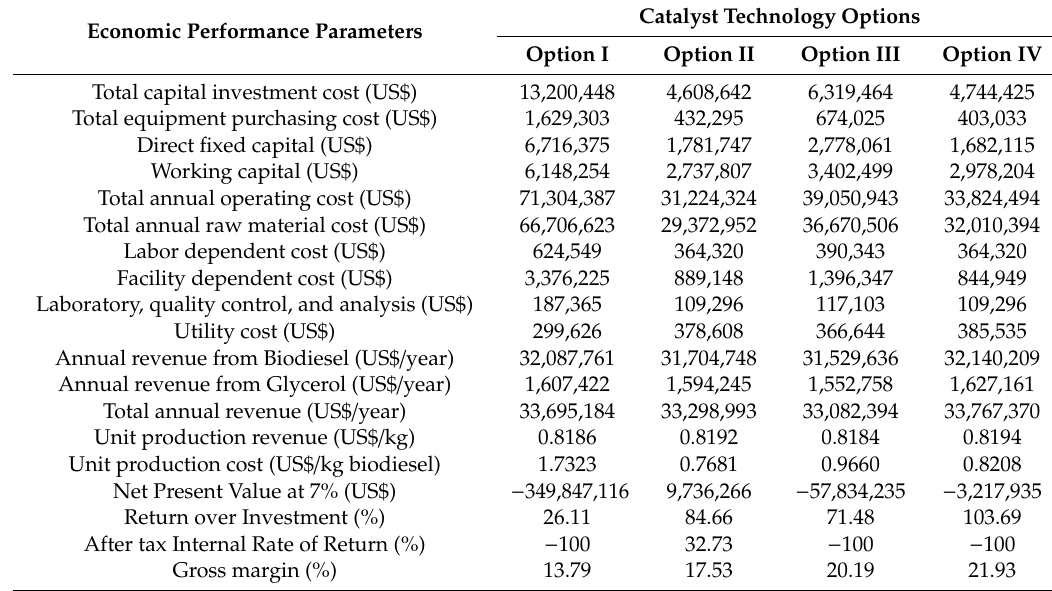
Table 6. Summary of the economic performance of the technology